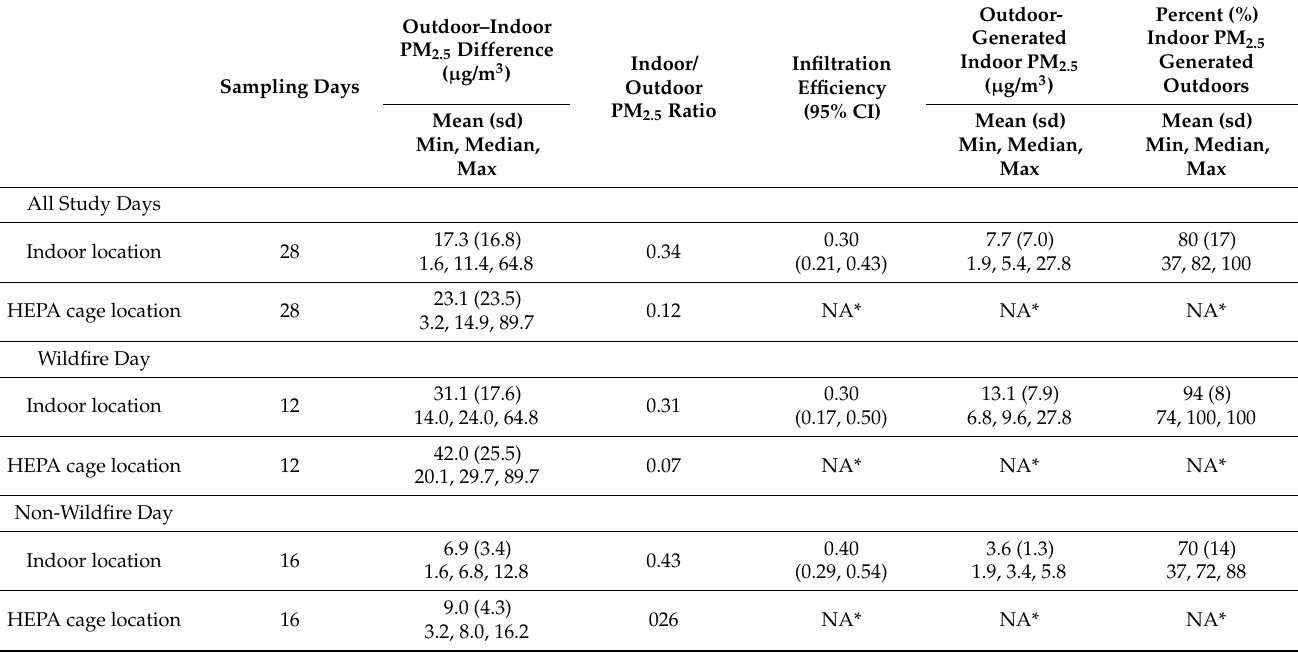
Table 2. Comparison of indoor and outdoor air quality